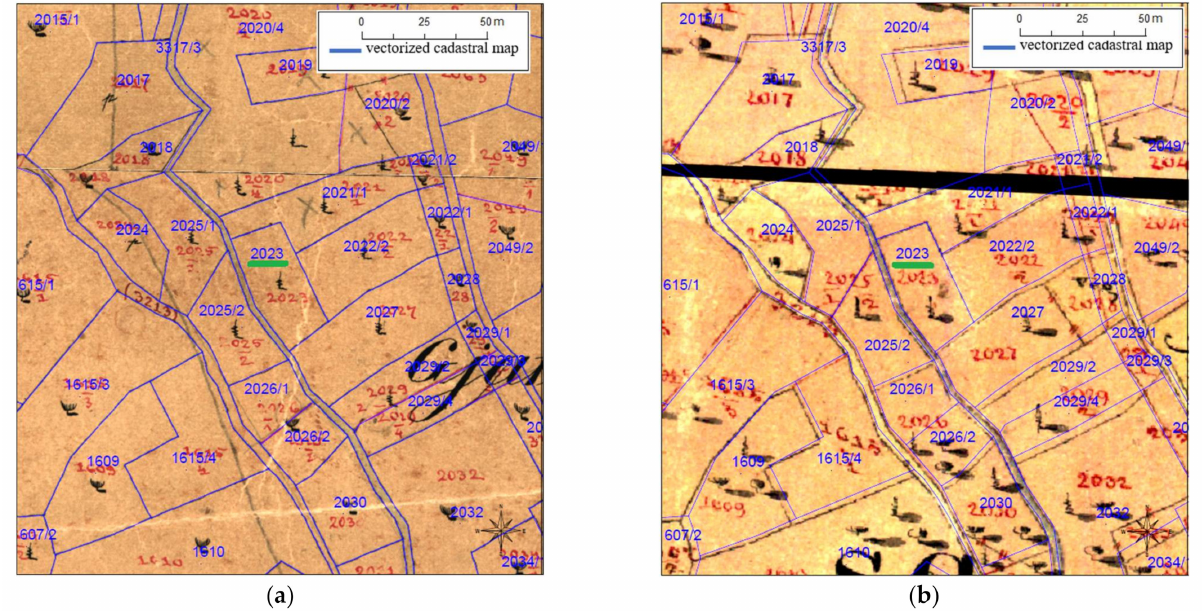
Figure 6. Example of cadastral survey inconsistency: ( a ) vectorized and cadastral map; ( b ) vectorized and historical cadastral map. Source: own